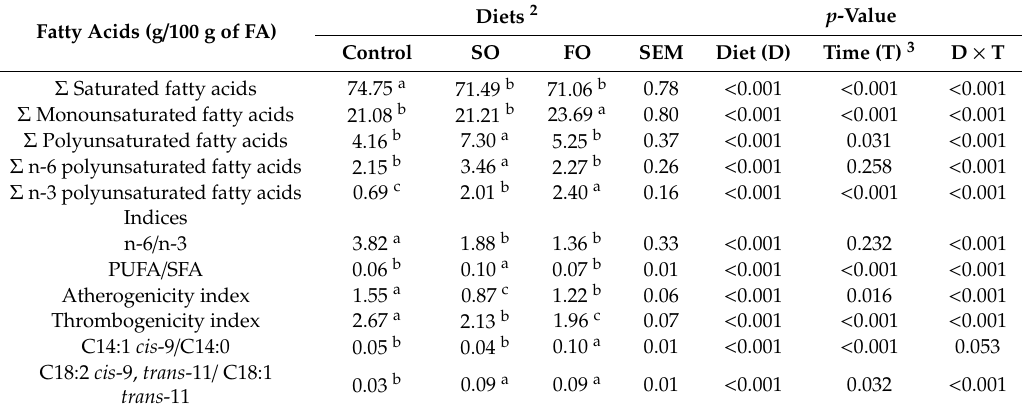
Table 4. Groups of main fatty acids, fatty acid ratios, health lipid indices, and estimated ∆ 9 -desaturase activity of milk fatty acids in the mammary gland from cows supplemented with control, soybean oil (SO), and fish oil (FO) 1 . Diets 2 p -Value Fatty Acids (g / 100 g of FA) Control SO